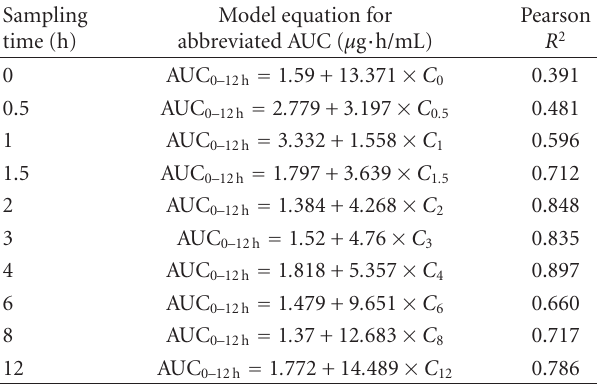
Table 3: Correlations and regression equations between AUC 0 − 12h and CsA concentration at each time